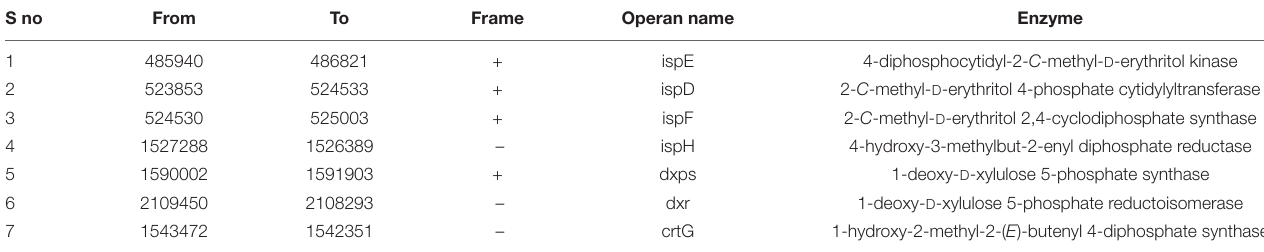
TABLE 4 | List of enzymes participating in the DPX pathway in E. profundum PHM11. S no